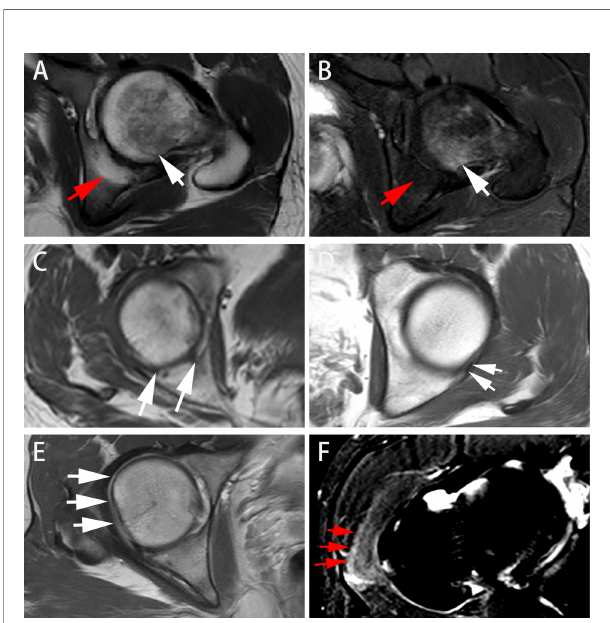
FIGURE 3 | Different presentations on axial MRI in axSpA patients with hip involvement. (A, B) A 27-year-old male demonstrated BME (white arrow) in left femoral head and fat deposition (red arrow) in left acetabulum on T1WI and SPAIR imaging, respectively. (C, D) A 25-year-old male manifested erosion (arrows) in right acetabulum and bone proliferation (arrows) in left acetabulum, respectively. (E) A 16-year-old male revealed thickened synovium with slightly high signal strip in right hip on contrast-enhanced T1WI (arrows). (F) A 31- year-old male showed gluteus medius edema (arrows) in right hip on SPAIR imaging. AxSpA: Axial spondyloarthritis; BME: Bone marrow edema; T1WI: T1-weighted imaging; SPAIR: Spectral attenuated inversion